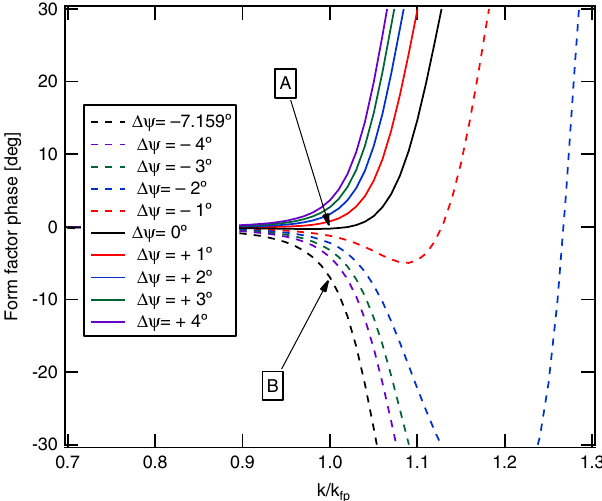
FIG. 17. Phase of the bunch form factor as determined by the implicit scalar approach, for the MAX IV parameters, as a function of the harmonic cavity voltage ratio k normalized to the flat potential voltage ratio k . The curves are plotted for fp − ψ different values of Δ ψ ¼ ψ . The points identified by h h; fp A and B correspond to the cases displayed in the plots of Figs. 1 and 2, respectively.